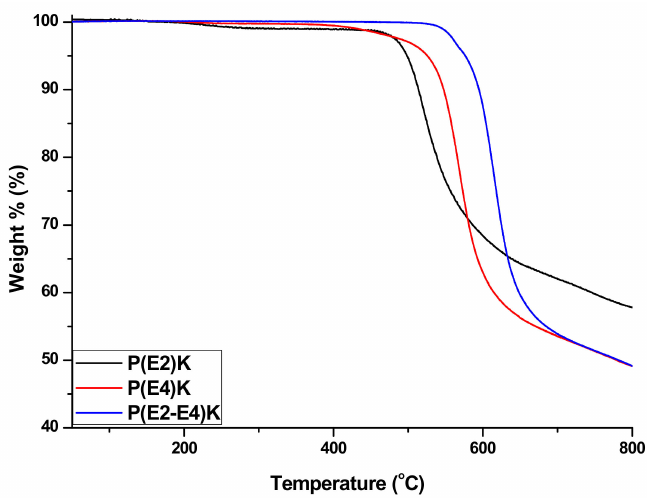
Figure 4. TGA curves of the PEEK homo and copolymers in a nitrogen